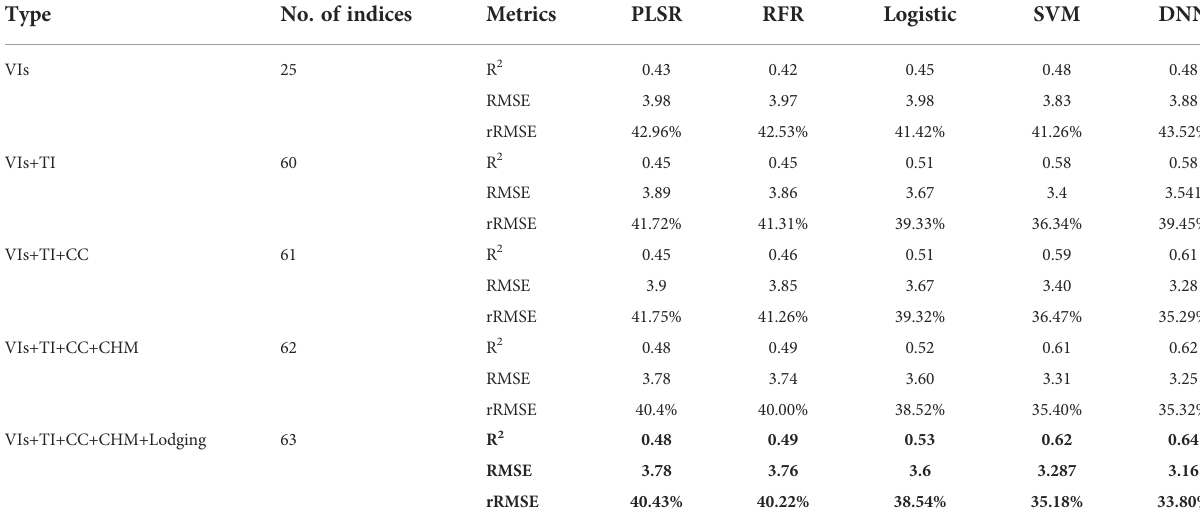
TABLE 4 The accuracy of estimation of different models for grain weight per plant.